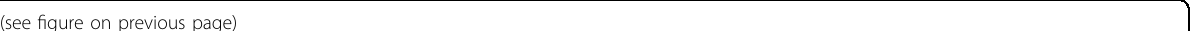
Fig. 2 PNO1 promotes HCC cell proliferation and inhibits cell apoptosis. A , B The construction of Hep3B PNO1- downregulation (sh-PNO1) and HLE PNO1-upregulation (PNO1) cell. C GSEA validating the correlation between PNO1 expression and the cell proliferation genes. D , E CCK-8 assay analysis of the impact of PNO1 knockdown or overexpression on Hep3B and HLE cell growth. F , G Colony formation assay showing the effects of PNO1 knockdown ( F ) or overexpression ( G ) on Hep3B and HLE cell growth. H , I Apoptotic rate was measured using annexin V/PI double staining in PNO1 knockdown ( H ) or overexpression ( I ) cells. J TEM analysis of cell ultrastructural characteristics in Hep3B sh-PNO1 and sh-Ctrl cells. Chromatin condensation and nuclear fragmentation are indicated by arrows. Scale bar = 20 μ m. K Western blotting analysis of apoptosis-related protein levels in cells as in ( A ) and ( B ). L , M Quanti fi cation of relative protein expression. N , O Apoptosis was also evaluated by TUNEL staining ( N ) and quanti fi cation of TUNEL positive cells ( O ). Scale bar: 50 μ m. Data were presented as mean ± SEM. n = 3 – 4. * p < 0.05, ** p < 0.01, *** p <